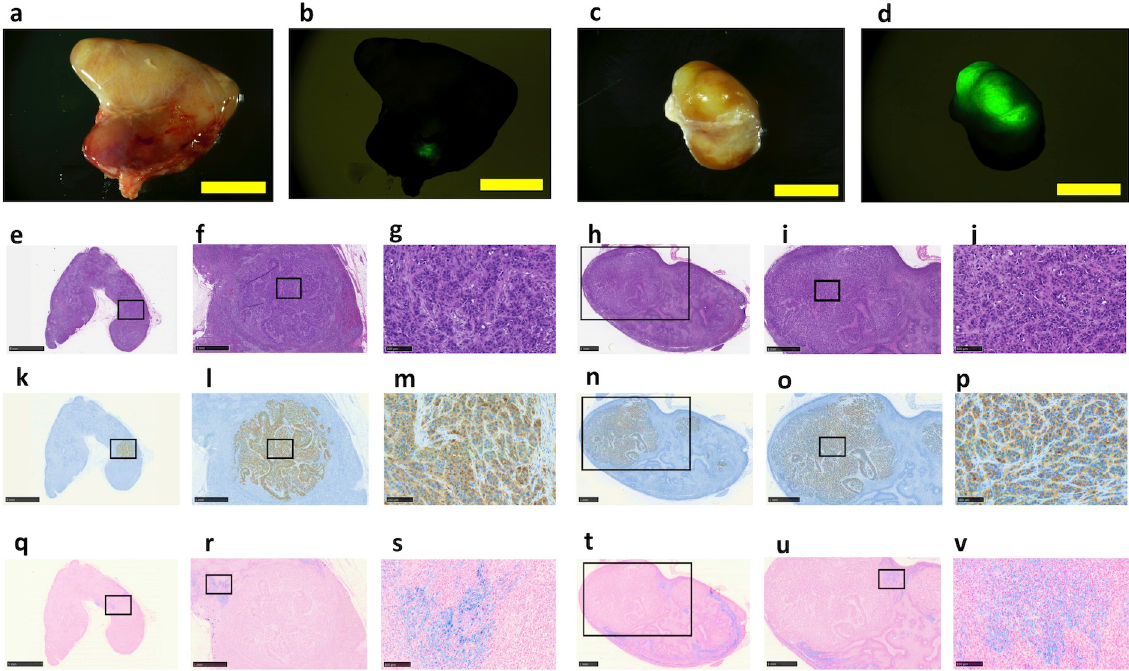
Fig 6. Fluorescence microscopy imaging and histological examinations of the two metastatic lymph nodes in the RAG2-knockout swine. ( a ) Bright-field view and ( b ) fluorescence microscopic view of the number 8 node. ( c ) Bright-field view and ( d ) fluorescence microscopic view of the number 13 node. ( e, f, g) Haematoxylin and eosin staining of the number 8 node showing metastatic tumour cells. ( h, i, j ) Haematoxylin and eosin staining of the number 13 node showing metastatic tumour cells. ( k, l, m ) Immunohistochemical analysis of the number 8 node and ( n, o, p ) number 13 node using an anti-green fluorescent protein (GFP) antibody. ( q , r, s ) Iron staining of the number 8 node and ( t, u, v ) number 13 node. Scale bar = 5 mm ( a – d , e , k , q ), 1 mm ( f , h , i , l , n , o , r , t , u ) and 100 μ m ( g , j , m , p , s , v ).